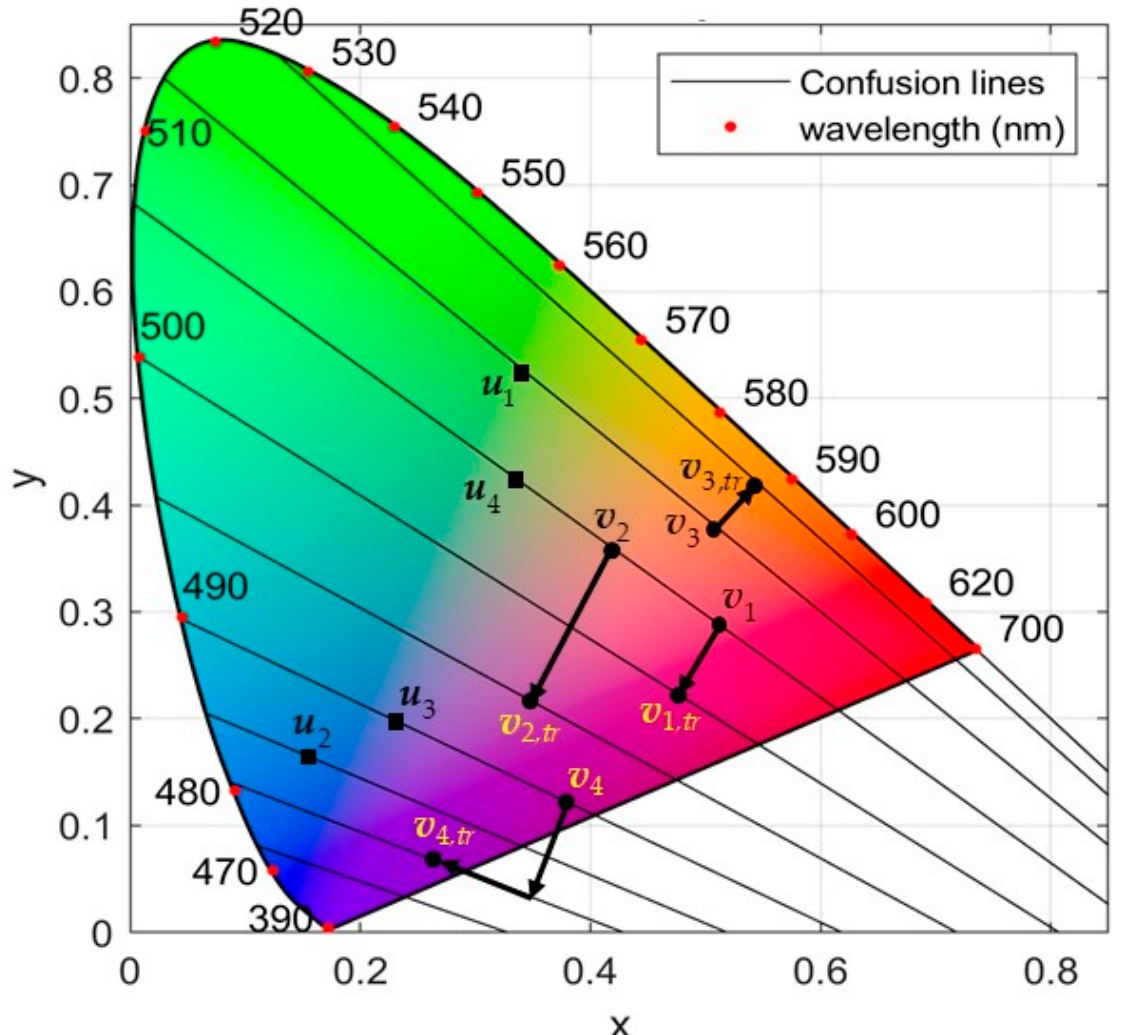
Figure 3. The key color translation process, where rank ( v 3 ) > rank ( v 1 ) > rank ( v 2 ) > rank ( v 4 )